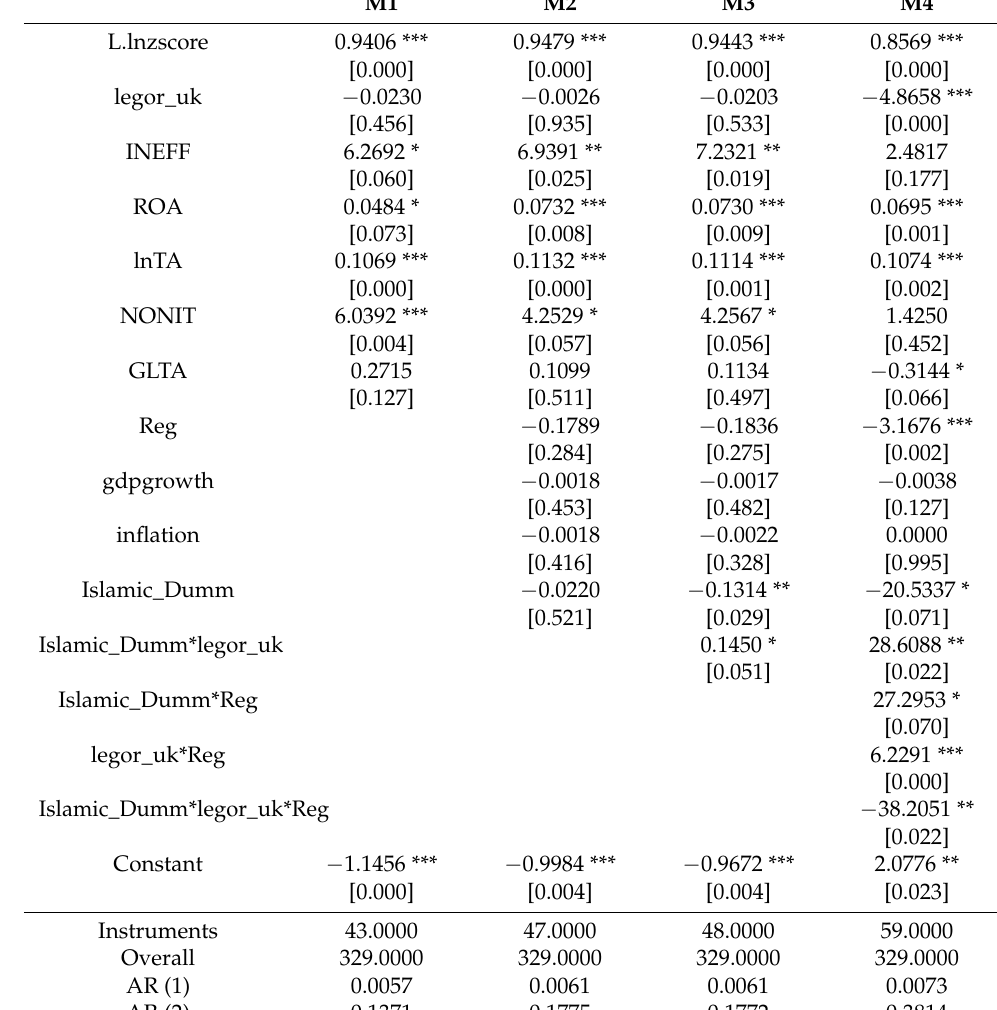
Table 8. Banks’ risk-taking and legal